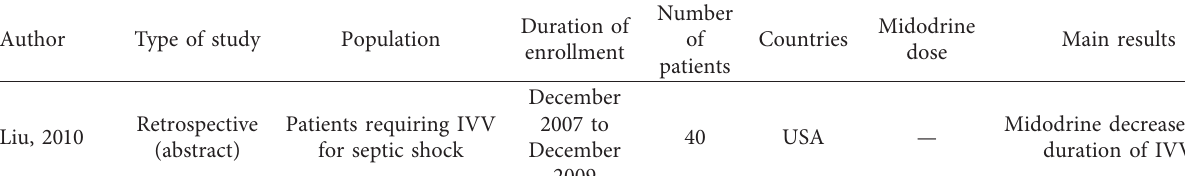
Table 1: Characteristics of the included